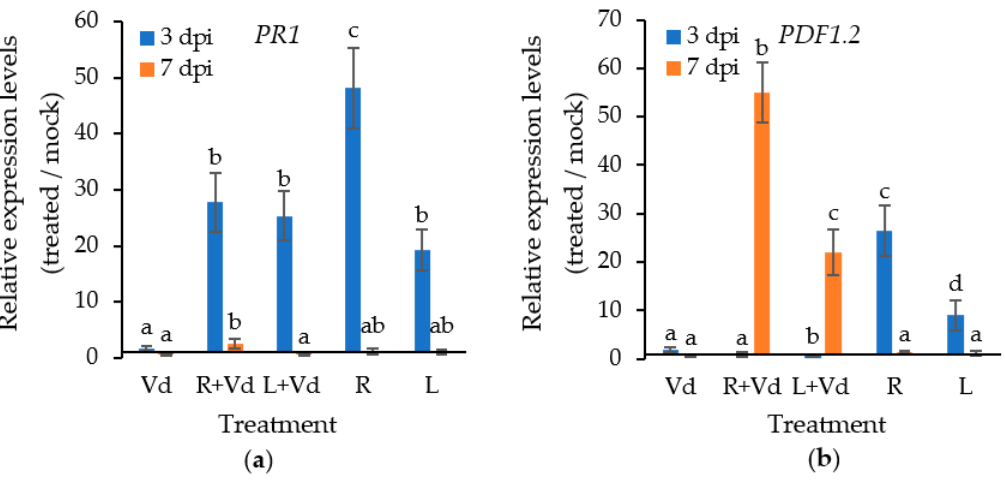
Figure 4 . Relative transcript levels of PR1 ( a ) and PDF1.2 ( b ) in the aerial plant parts of A. thaliana leaf injected (L + Vd) or root drenched (R + Vd) with autoclaved spores of V. dahliae or mock inoculated (positive control, Vd) in response to infection with V. dahliae at 3 and 7 dpi. The samples for RNA isolation were collected at 3 and 7 days post inoculation (dpi) with the pathogen. The expression levels of PR1 and PDF1.2 were normalized to the expression of the reference gene At4g26410 measured in the same samples and they are presented in comparison to the normalized expression level of the respective gene in the mock treatment. Columns represent means of three biological and technical replications per treatment ( n = 9, ± SE). At each day, different letters denote statistically significant differences between treatments ( p < 0.05) according to LSD test.